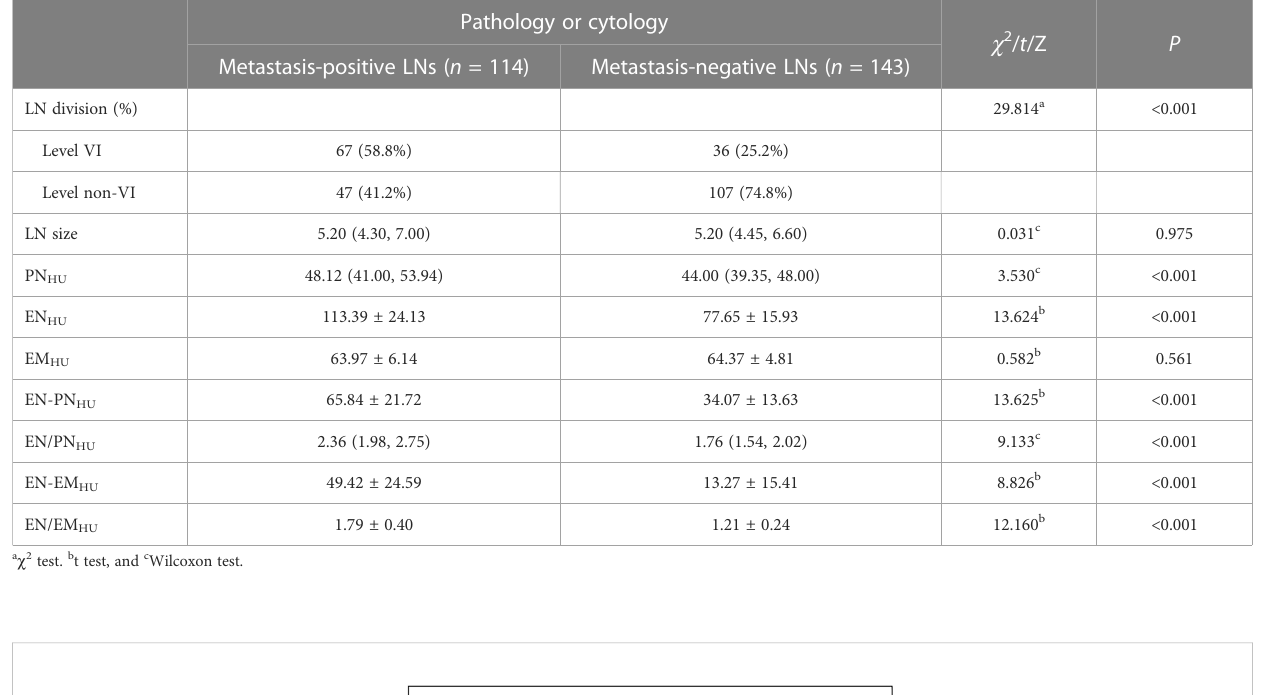
TABLE 2 Distribution of LN size, division, and